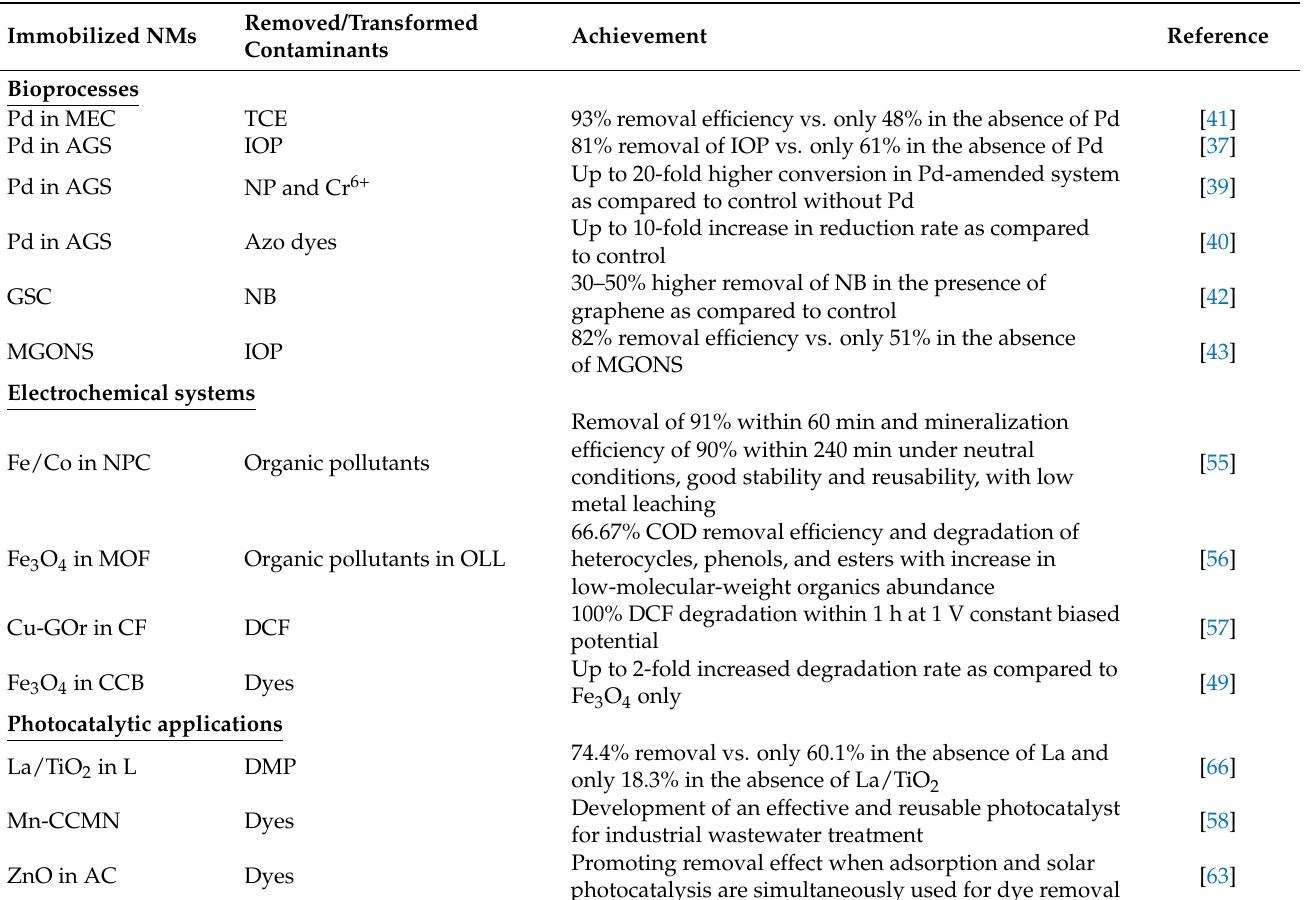
Table 2. Application of immobilized nanomaterials for the removal of recalcitrant pollutants. Immobilized